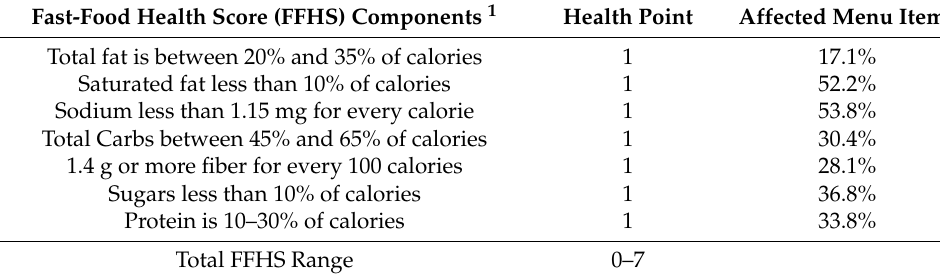
Table 1. Fast-Food Health Score (FFHS)